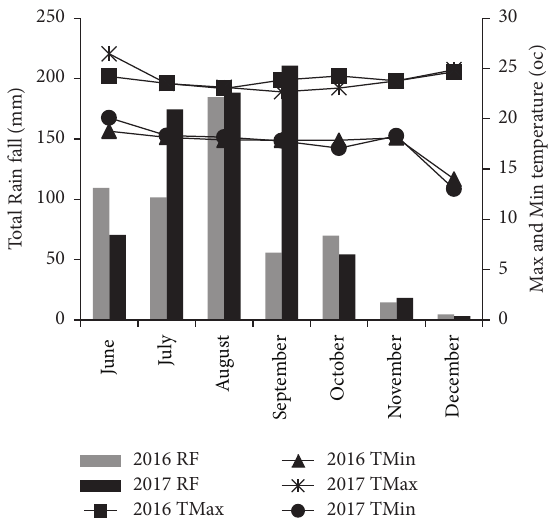
Figure 1: Total rainfall and minimum and maximum temperature from June to December (2016–2017) at Debre Zeit.